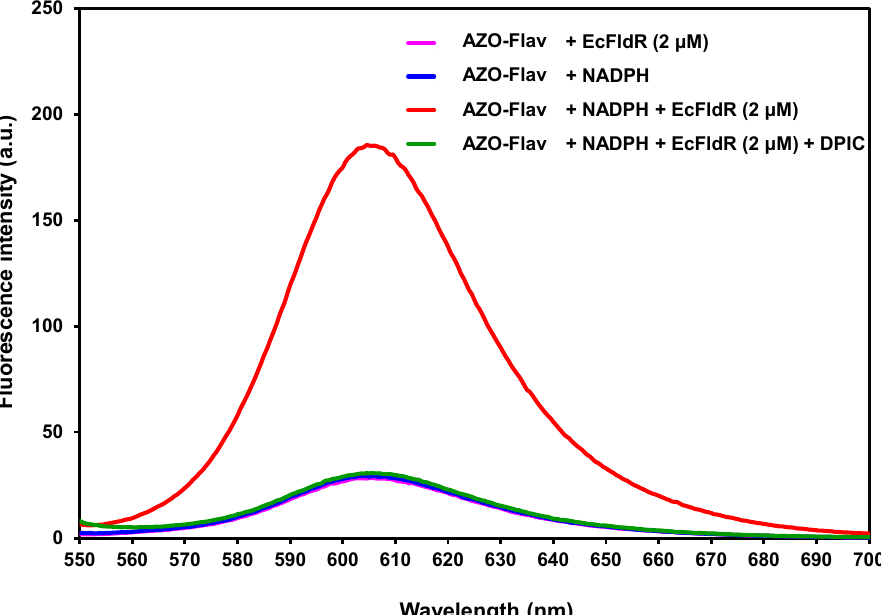
Figure 3. The fluorescent response of AZO-Flav (10 μ M) in the presence of NADPH (50 μ M) catalyzed by Ec FldR in 100 mM hypoxic phosphate buffer (pH 7.4) with and without DPIC (50 μ M). The spectra were measured at the excitation wavelength of 540 nm.